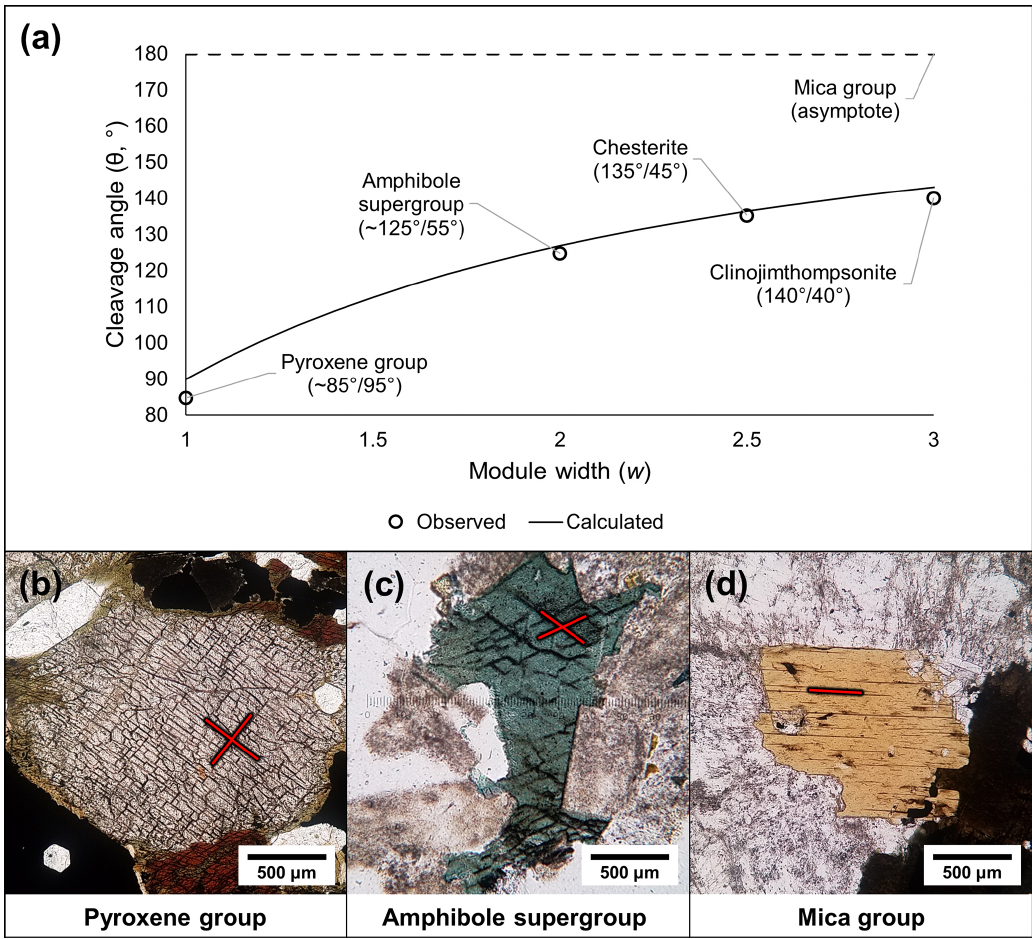
Figure 9. Cleavage angles of the biopyriboles. (a) The observed and calculated cleavage angles (see Sect. S1.4) show strong correlation. (b–d) Plane-polarized light photomicrographs of biopyribole minerals, showing typical cleavages: (b) pyroxene group ( ∼ 85 ◦ /95 ◦ ; compare with Fig. 6a), (c) amphibole supergroup ( ∼ 125 ◦ /55 ◦ ; compare with Fig. 6d), and (d) mica group (one basal cleavage, i.e., 180 ◦ /0 ◦ ; compare with Fig.